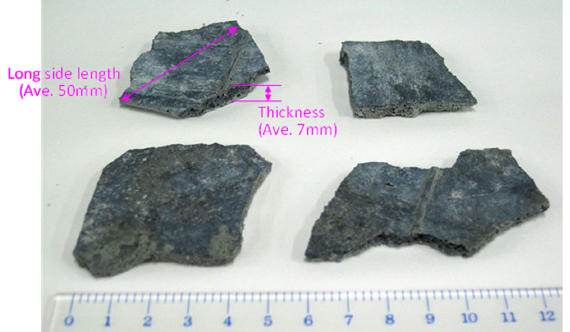
Figure 2. Plate-shaped slag produced by pilot plant.